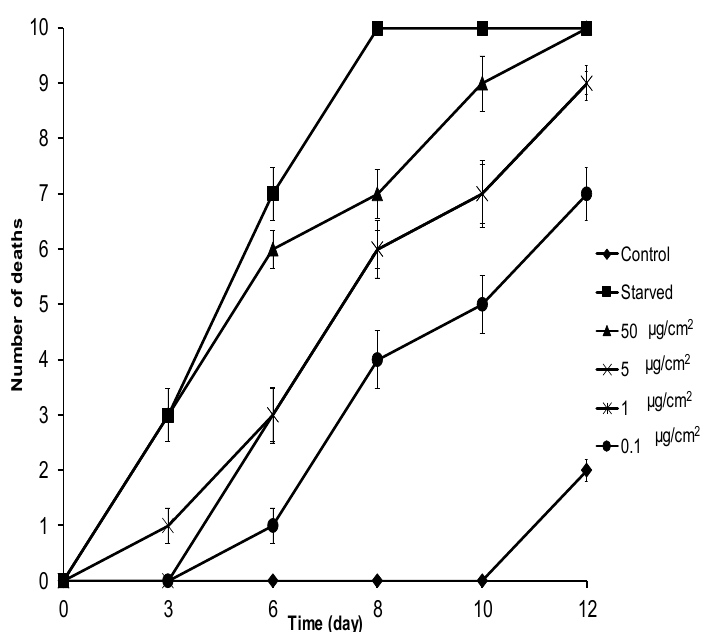
Figure 5. Cumulative mortality of E. paenulata larvae fed with leaves treated with 1 at different concentrations. All treatments were in triplicate ( n = 10). Starved represents food-deprived treatment. Error bars show standard deviation; where error is not shown, it is smaller than the symbol.